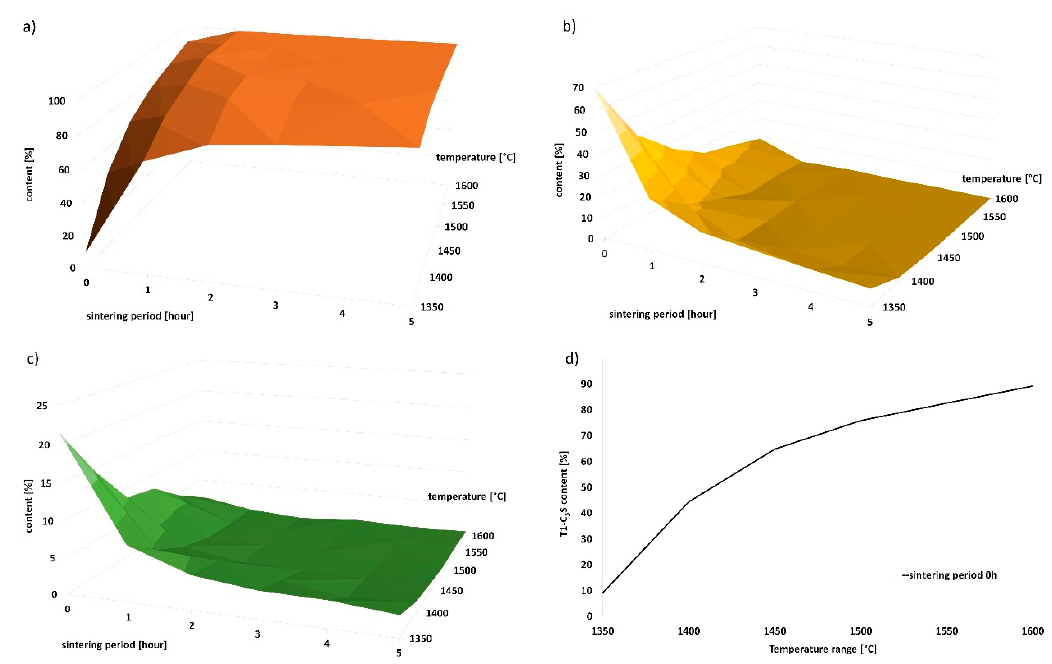
Figure 3. Graphic representation of change in mineral composition with increasing sintering period. ( a ) T1–C 3 S content; ( b ) β -C 2 S content; ( c ) f-CaO content; ( d ) linear dependence of the amount of T1–C 3 S on increasing temperature.